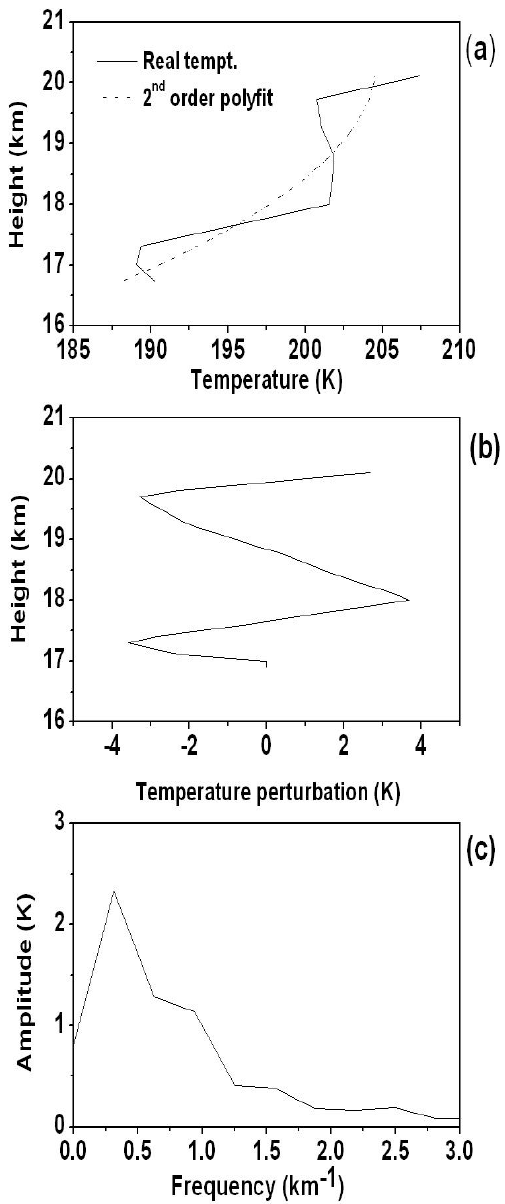
Fig. 9. Figure shows signature of temperature modulation by con- vection generated wave activity. (a) Vertical temperature profile taken on 24 August 1999, 00:00GMT using GPS Sonde launched from ORV Sagar Kanya, (b) temperature perturbation from mean trend and (c) spectrum of the temperature perturbation from mean trend in the height profile of temperature.